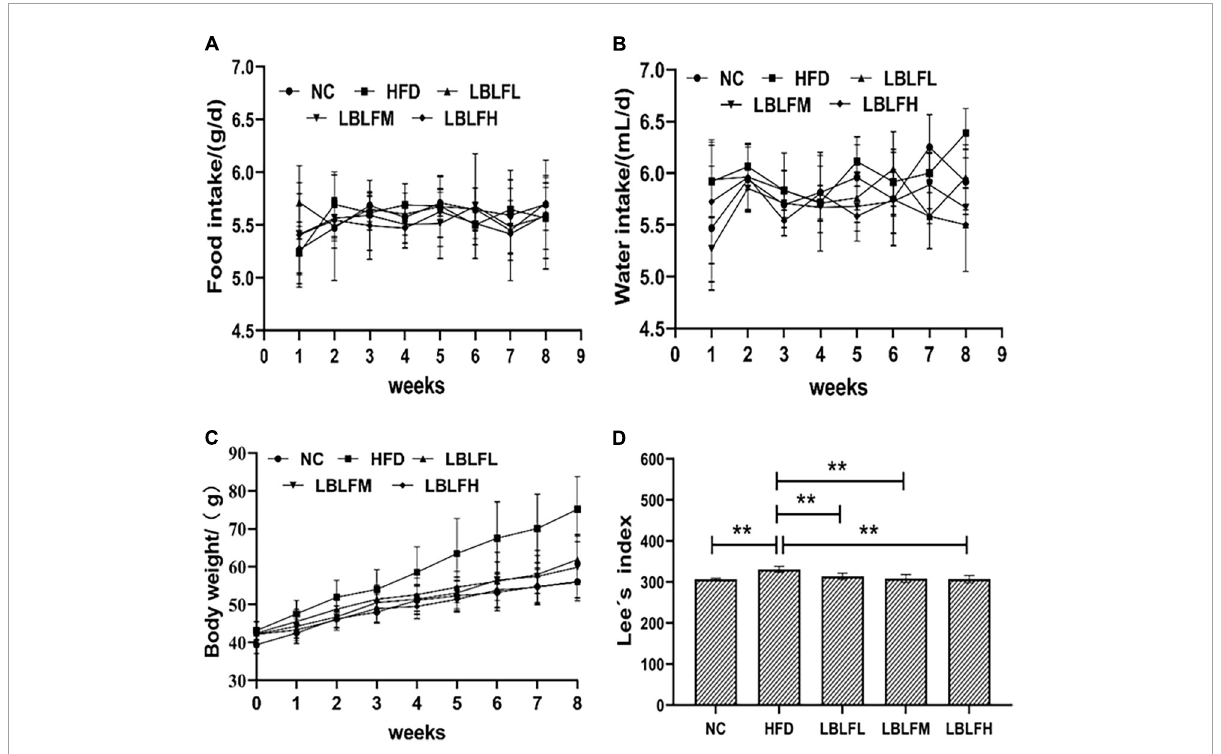
FIGURE1 Effects of LBLF supplement on (A) food intake, (B) water intake, (C) body weight, and (D) Lee’s index in obese mice. (* p < 0.05) and (** p < 0.01) vs. HFD